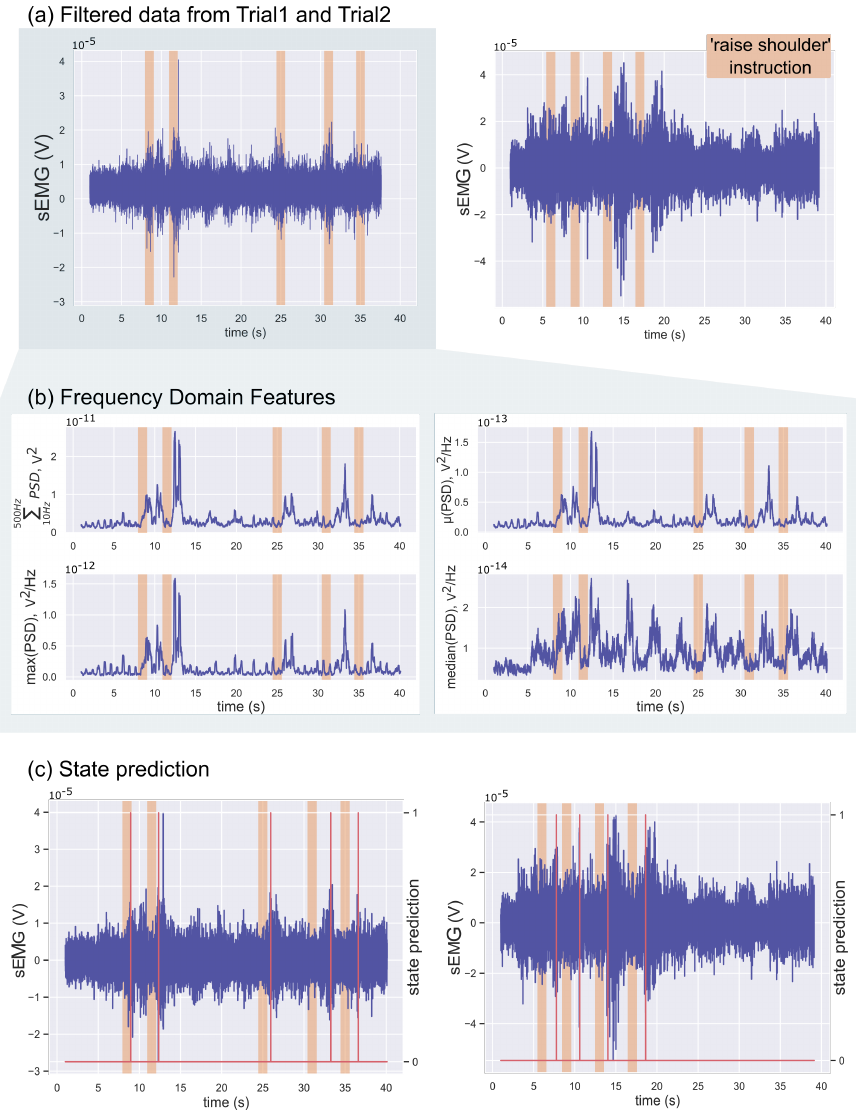
Figure 8. EMG data and classification for Participant1. ( a ) The filtered data from the trapezius muscle of the two Participant1 trials; Trial1 on the left and Trial2 on the right. ( b ) The four classification features from the Trial1 data. ( c ) The state prediction for the two